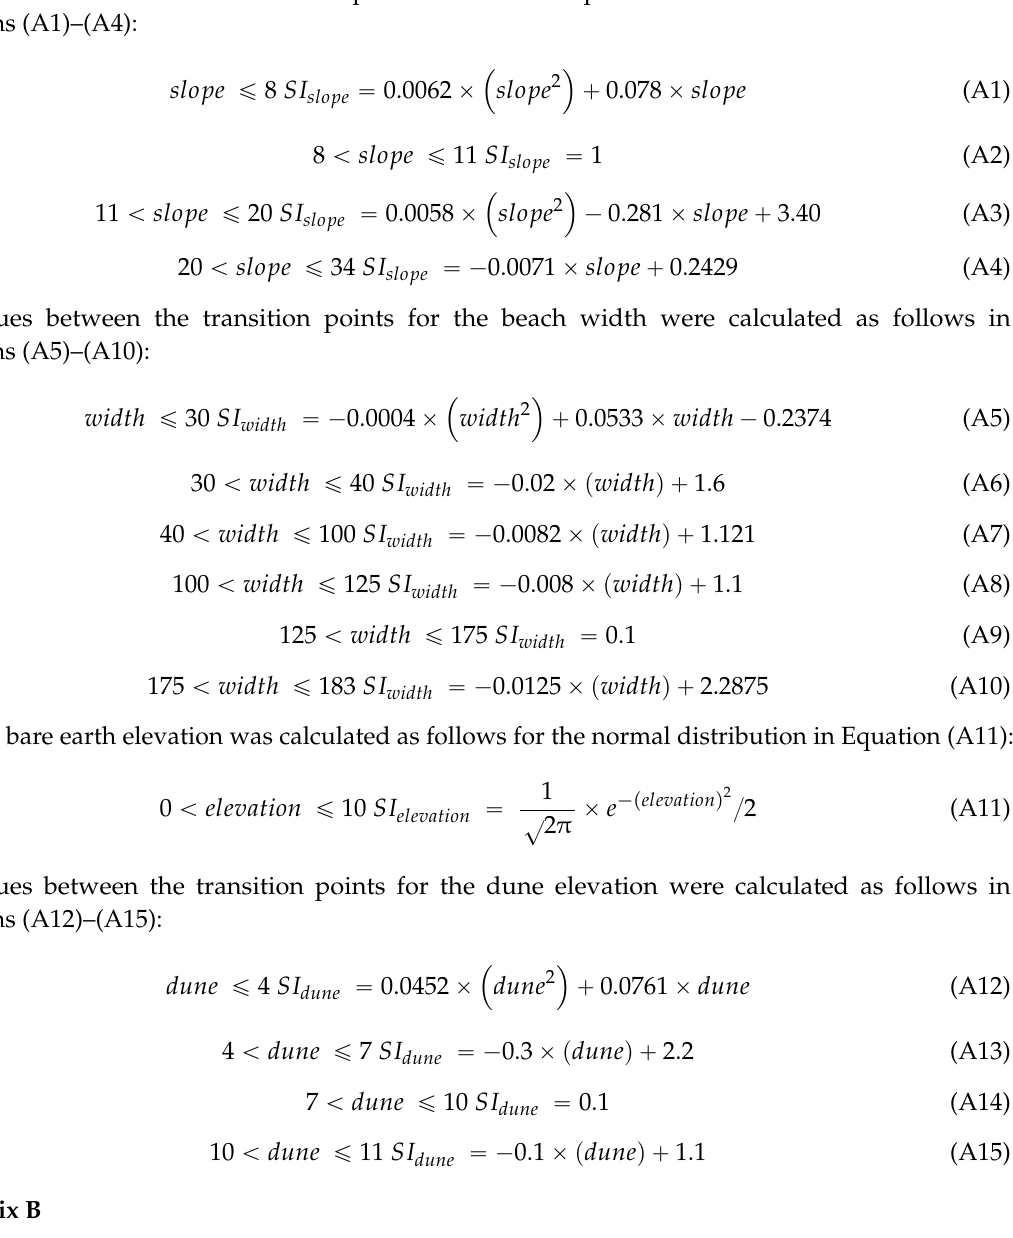
Table B1. Experimental design used to weight parameters for 57 model runs that utilized all four parameters. Four additional model runs, each using only one parameter, were also included in the